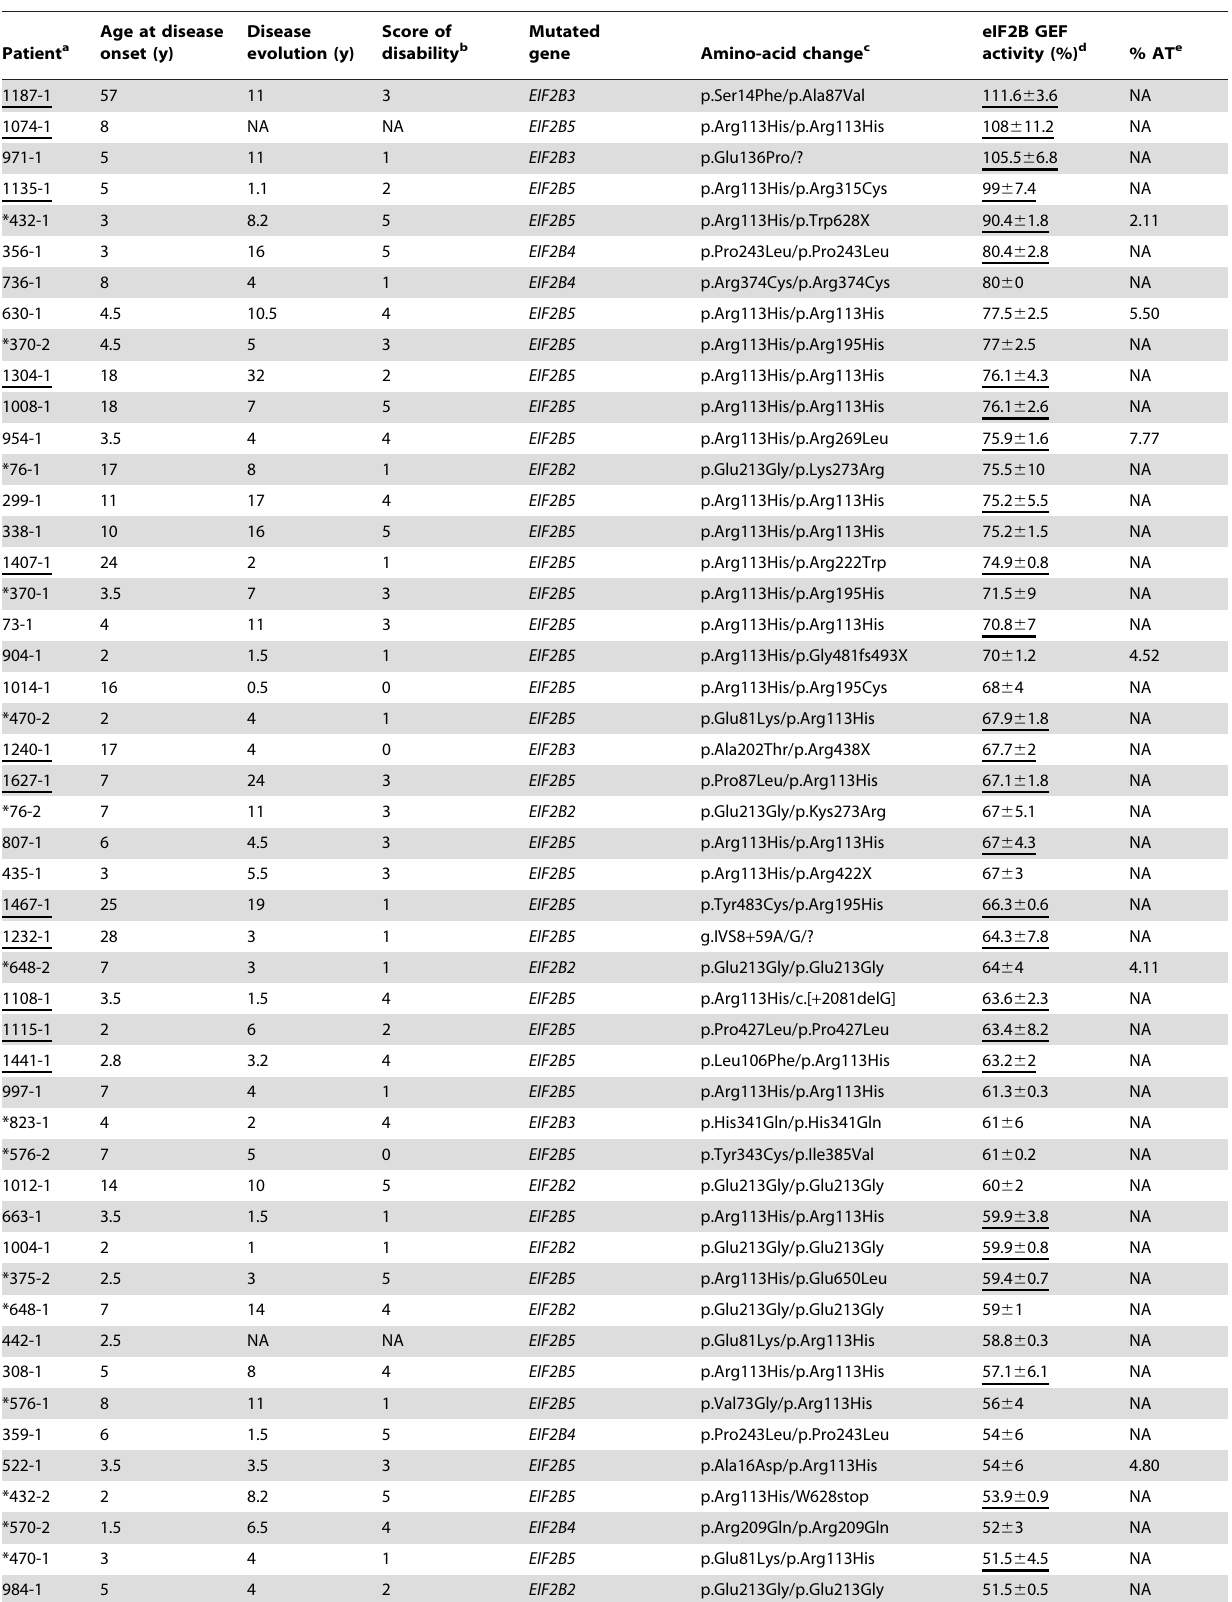
Table 1. Clinical data and eIF2B GEF activity measured in lymphoblasts from the 63 eIF2B-mutated patients.